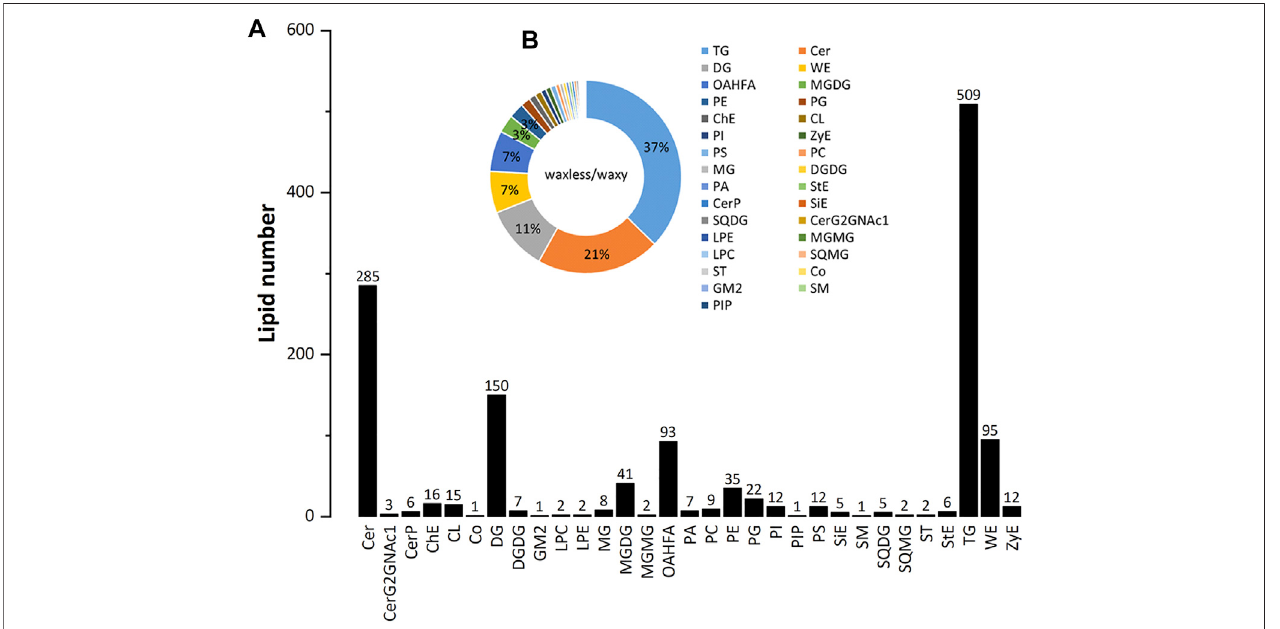
FIGURE 3 | The statistical chart of numbers of lipid subclass in wheat leaves. (A) Abscissa is the detected lipid subclasses; ordinate is the number of lipids. (B) Different lipid subclasses are represented by different colors, and the proportion is expressed by the size of the color block area. For the corresponding relationship and proportion between each lipid subclass and color, see the legend on the